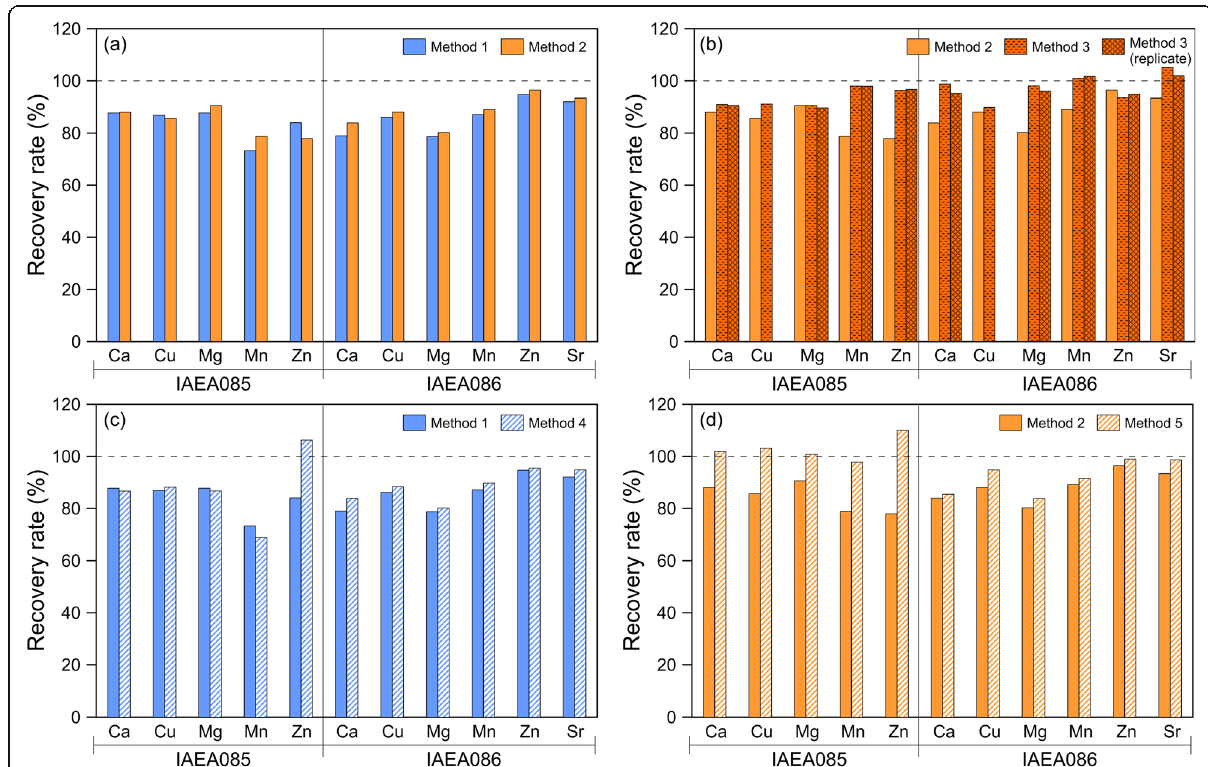
Fig. 2 Bar charts showing the recovery rates of trace elements obtained from five different digestion methods; Effects of temperature ( a ), H 2 O 2 ( b ), and number of digestion ( c ) and ( d ).The recovery rate was calculated by dividing measured value by certified value. Both IAEA085 and IAEA086 samples were prepared in duplicate using the method